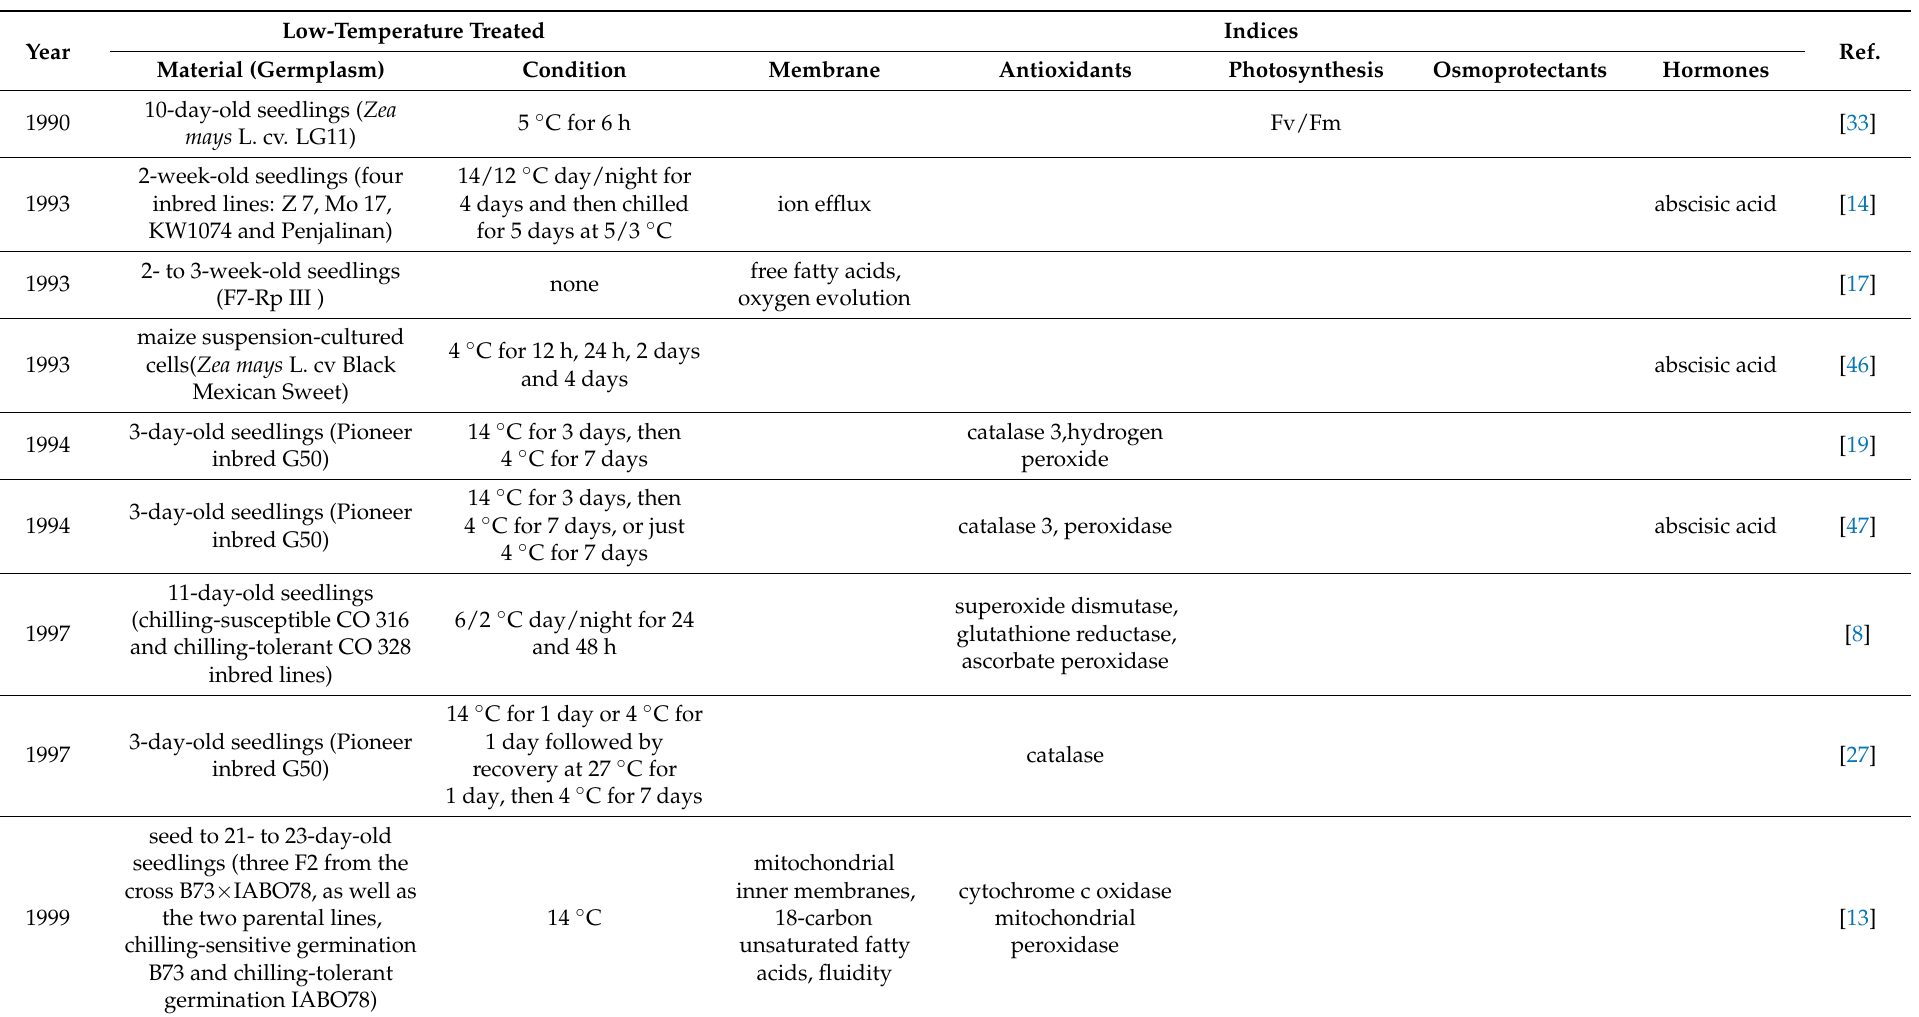
Table 1. Measurement of physiological and biochemical indices under low-temperature